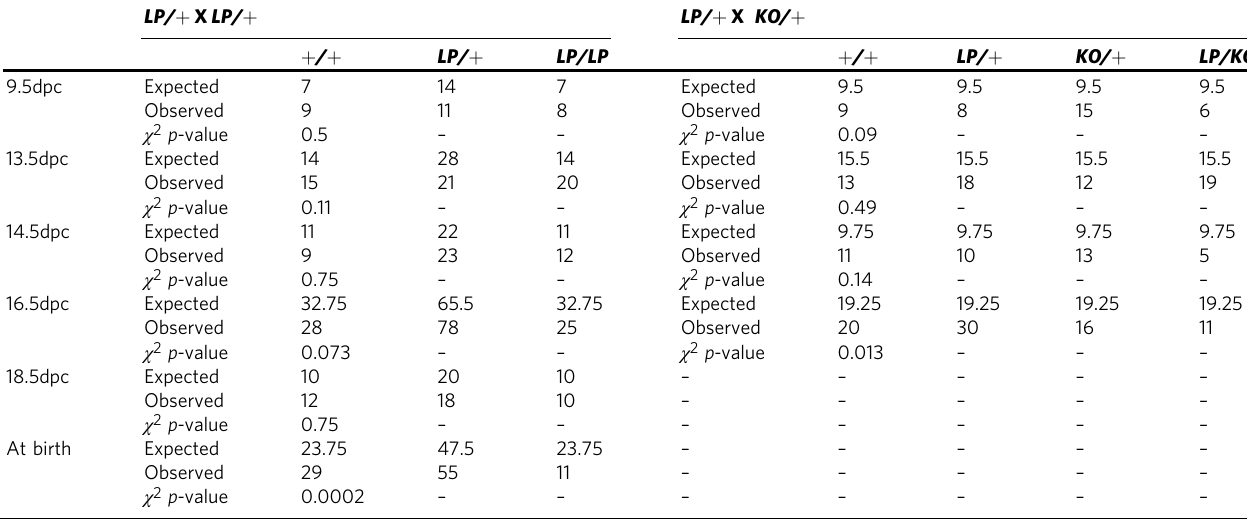
Table 2 Observed and expected number of embryos of various genotypes obtained from Brca2 LP/ + intercross and Brca2 LP/ + X Brca2 KO/ + cross at different days of